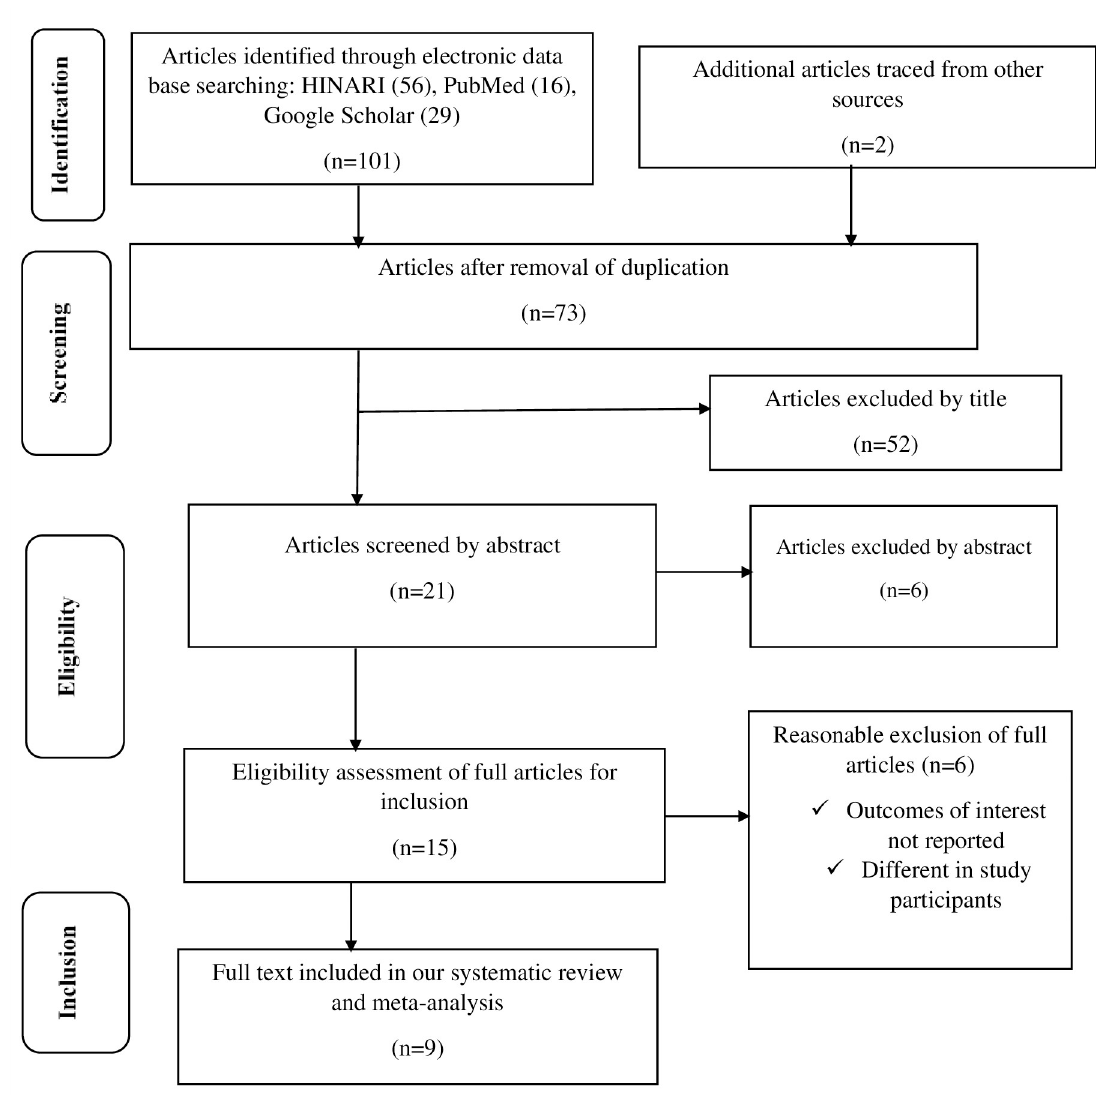
Fig 1. Flow chart diagram describing selection of studies for the systematic review and meta-analysis of visual impairment and associated factors among children in Ethiopia, 2021.